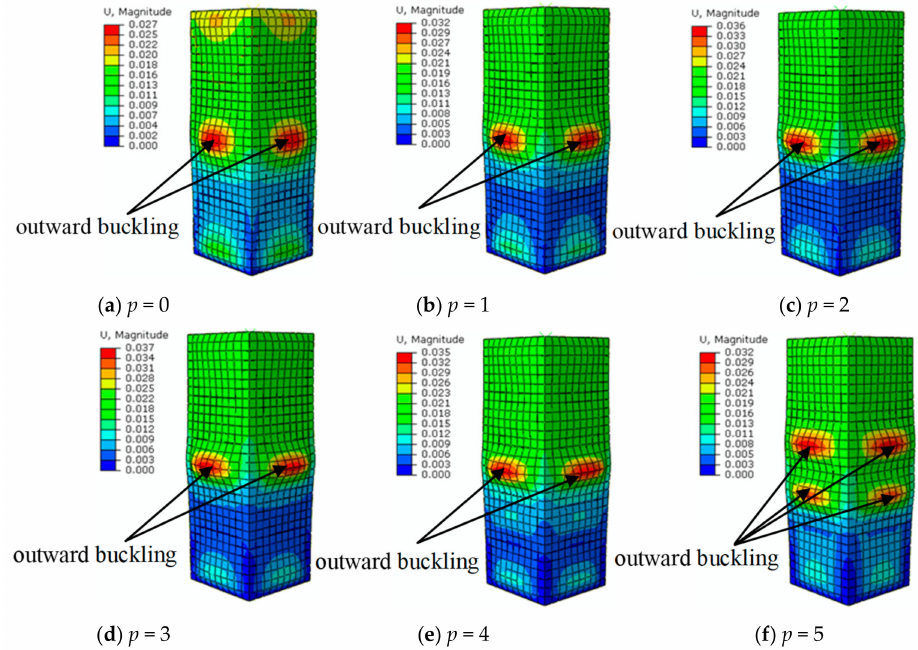
Figure 9. Failure modes of squared concrete-filled steel tube (SCFST) stub columns with di ff erent combined times of